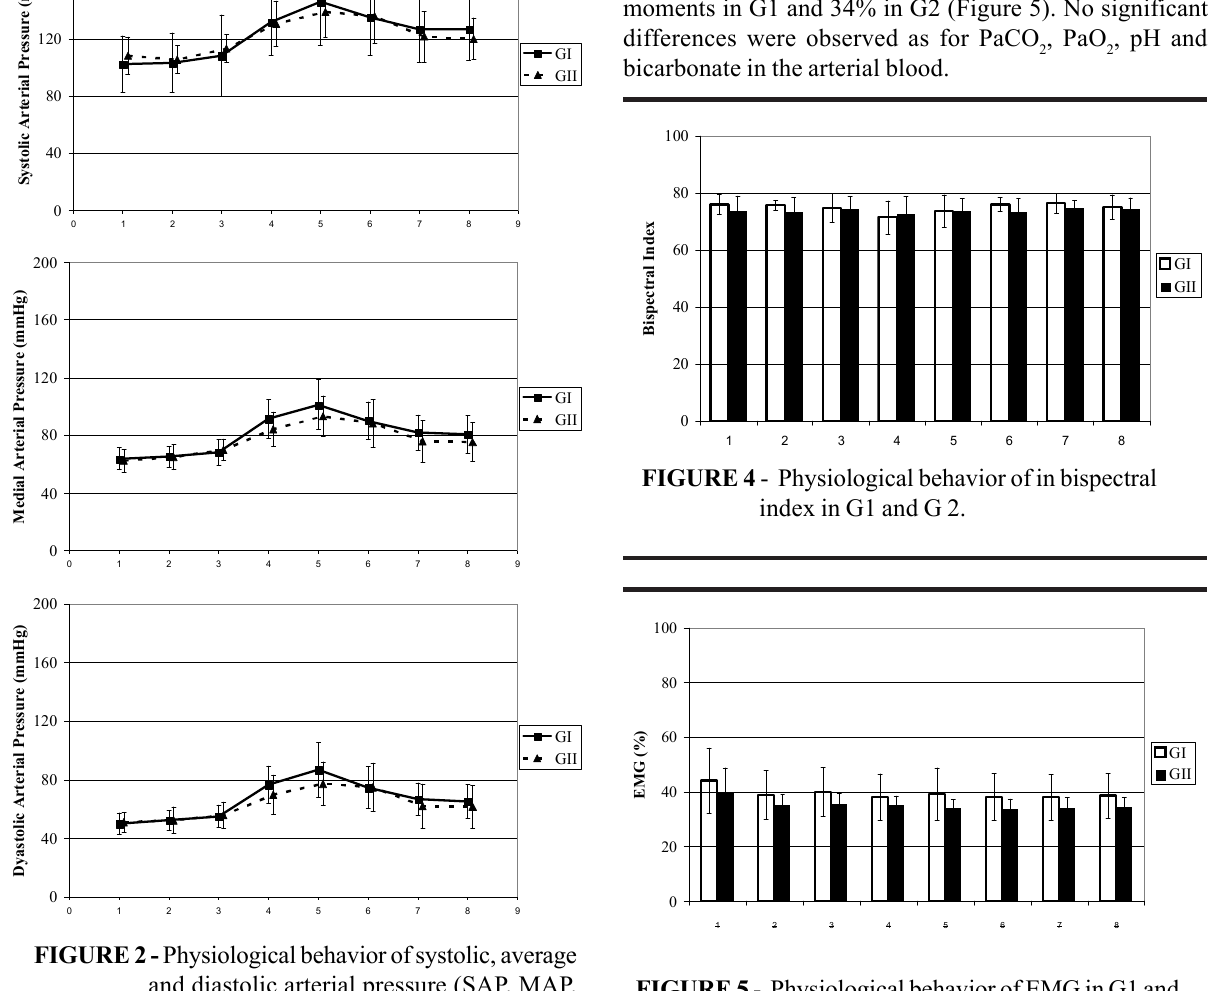
FIGURE 5 - Physiological behavior of EMG in G1 and